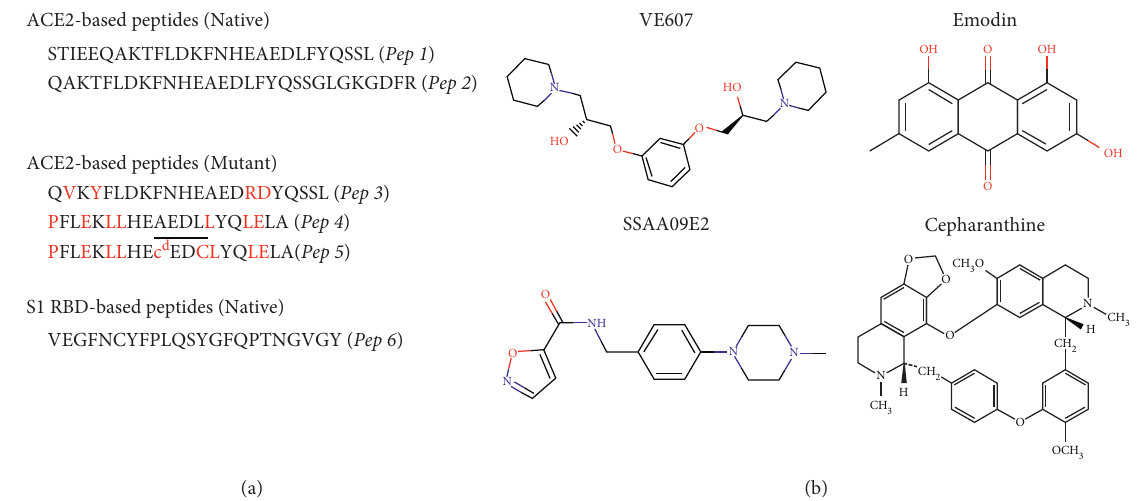
Figure 3: Peptide sequences and small molecule structures. (a) Peptide sequences derived from ACE2 peptidase domain with and without modifications (Pep 1–Pep 5). Pep6 was derived from the S1 RBD sequence. (b) Chemical structures of small molecules VE607, Emodin, SSAA09E2, and cepharanthine. Usually D-amino acids in one letter code is described with